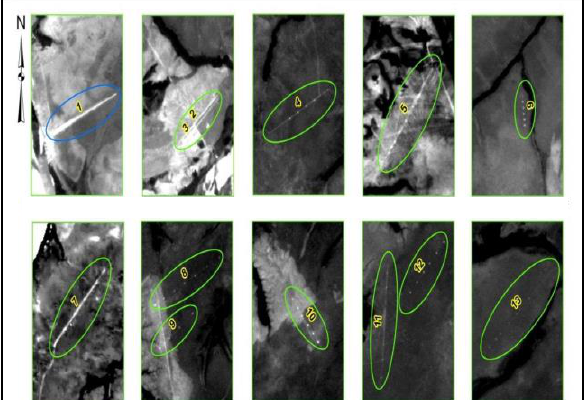
Figure 4. Unauthorized and authorized airstrips identified